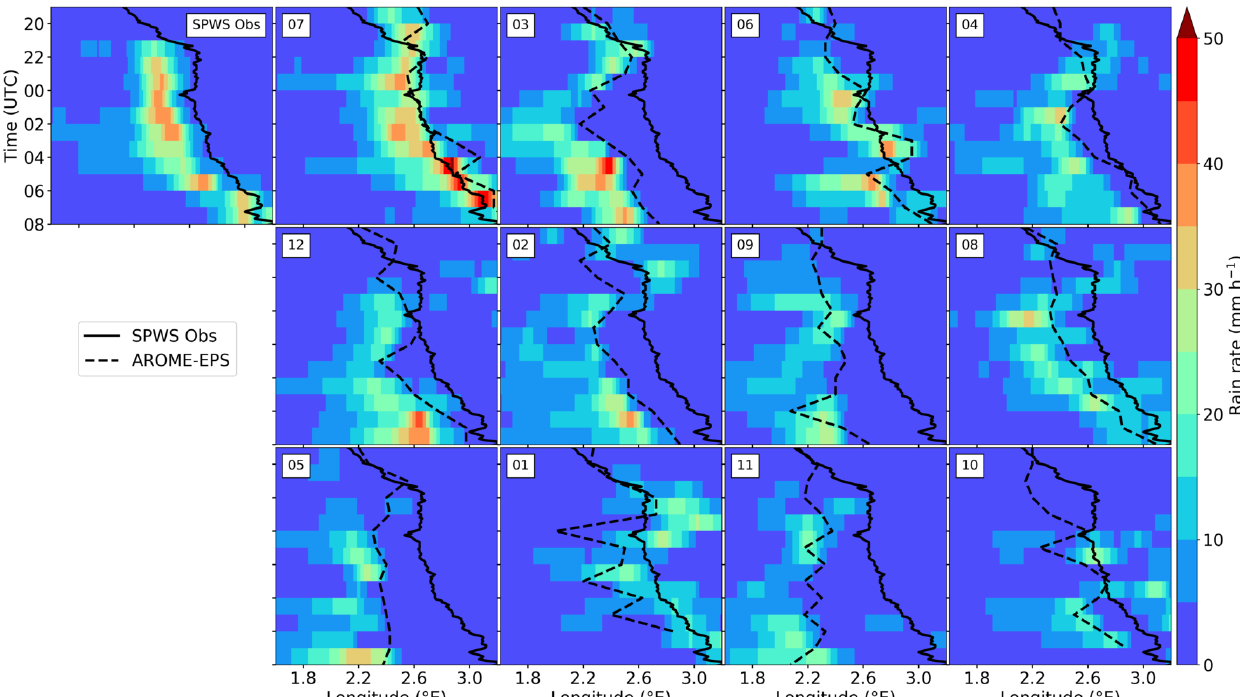
Figure 16. Hovmöller diagram of the mean trough’s longitude over the Aude valley observed with SPWS analyses and predicted by the members of the AROME-EPS between 19:00UTC on 14 October and 08:00UTC on 15 October. The mean hourly rain rate observed by SPWS ANTILOPE or predicted by AROME-EPS over the Aude valley [43.15–43.33 ◦ N] is shown as a function of the longitude. Members are ranked as in Fig. 9.